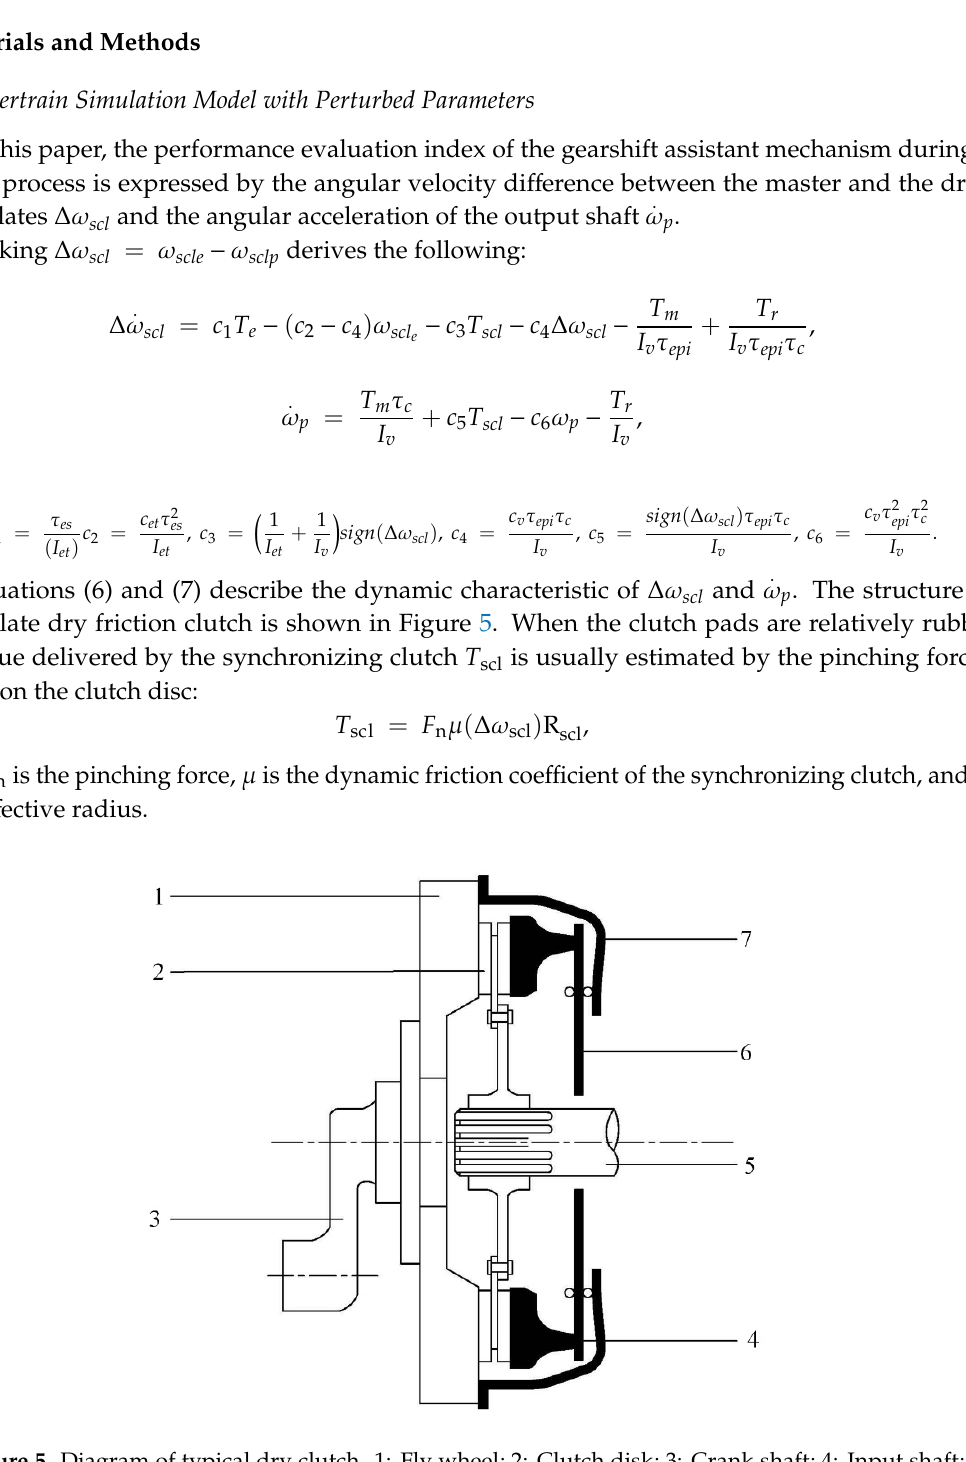
Figure 6. Friction coefficient characteristics of clutch pads.